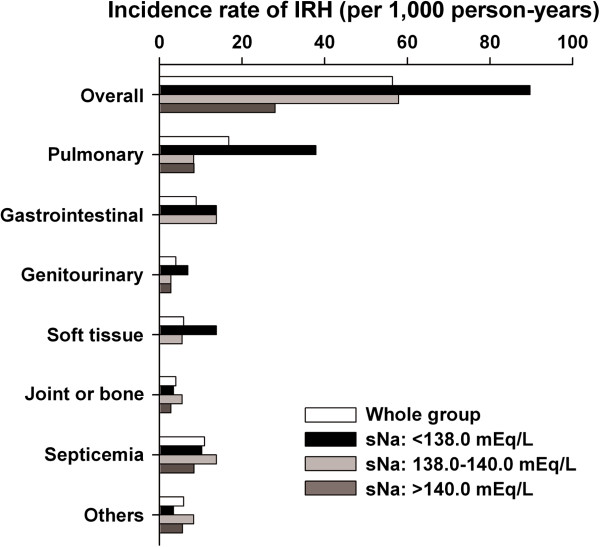
Incidence rate of each subtype of infection-related hospitalization according to serum sodium level tertiles. Abbreviations: IRH, infection-related hospitalization; sNa, serum sodium level.